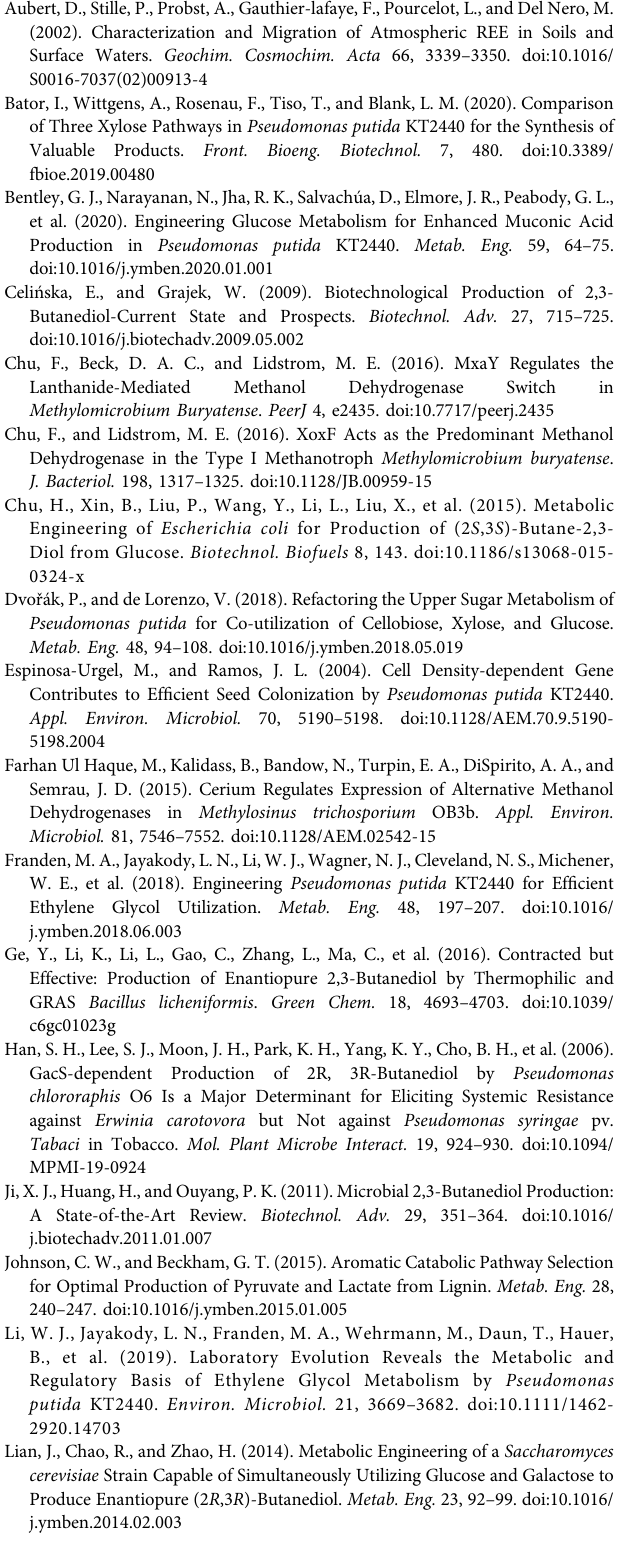
Tabaci in Tobacco. Mol. Plant Microbe Interact. 19, 924 – 930. doi:10.1094/